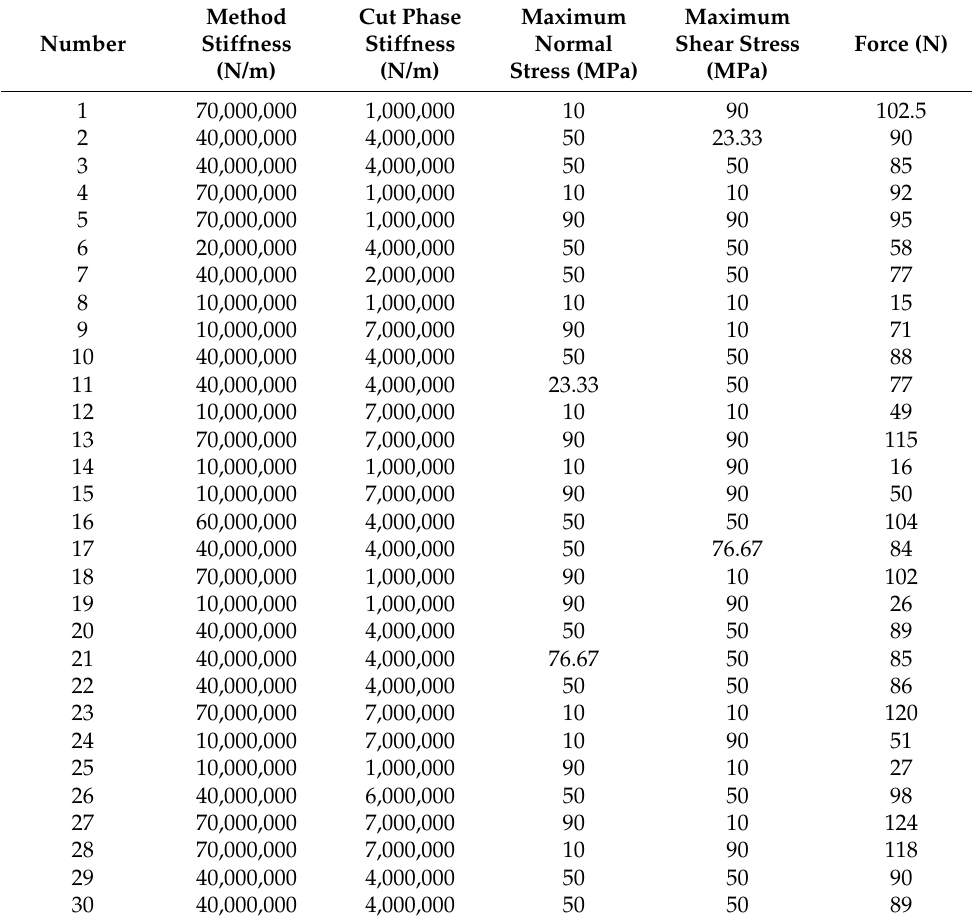
Table 9. The design and results of a response surface for bond